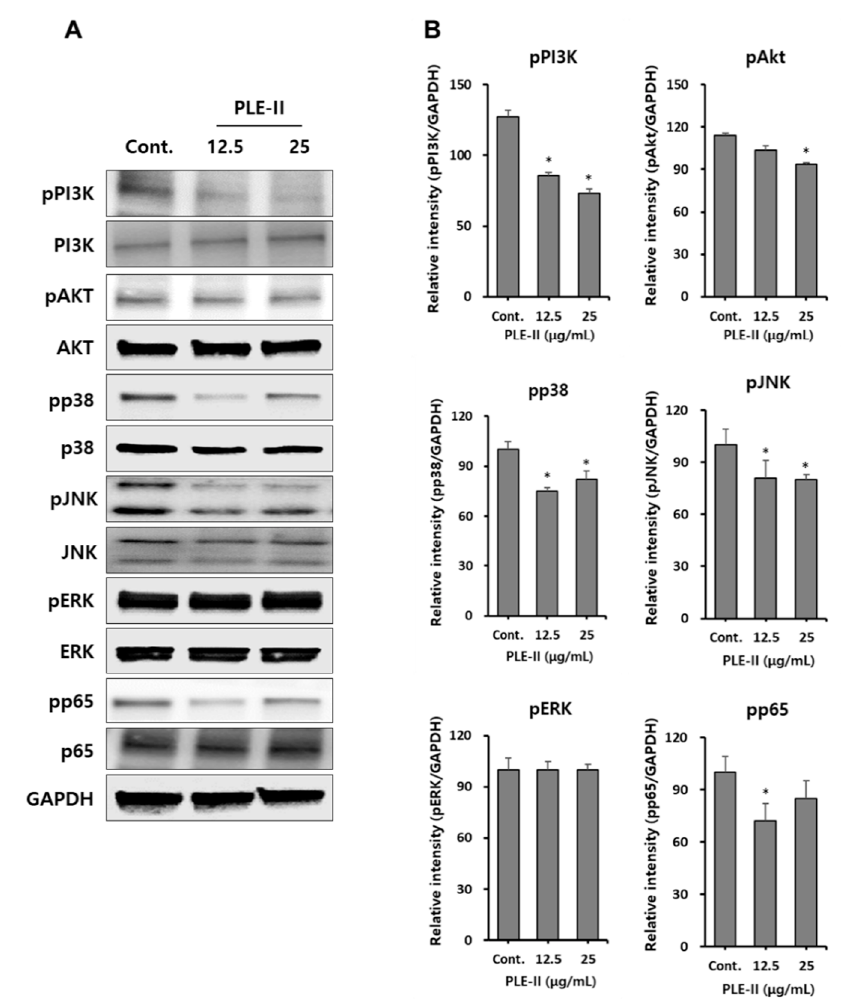
Figure 5. PLE-II inhibited PI3K/AKT, p38, JNK and NF- κ B p65 signal pathways in HUVECs. ( A ) Cells were treated with PLE-II at the indicated concentrations for 24 h. Whole-cell lysates were then immunoblotted with specific antibodies as indicated in the left side of each panel. β -Actin served as the internal loading control. ( B ) The bar charts display the intensity of each band after normalization to the intensities of the β -actin using the ImageJ software. * p < 0.01 vs. the control